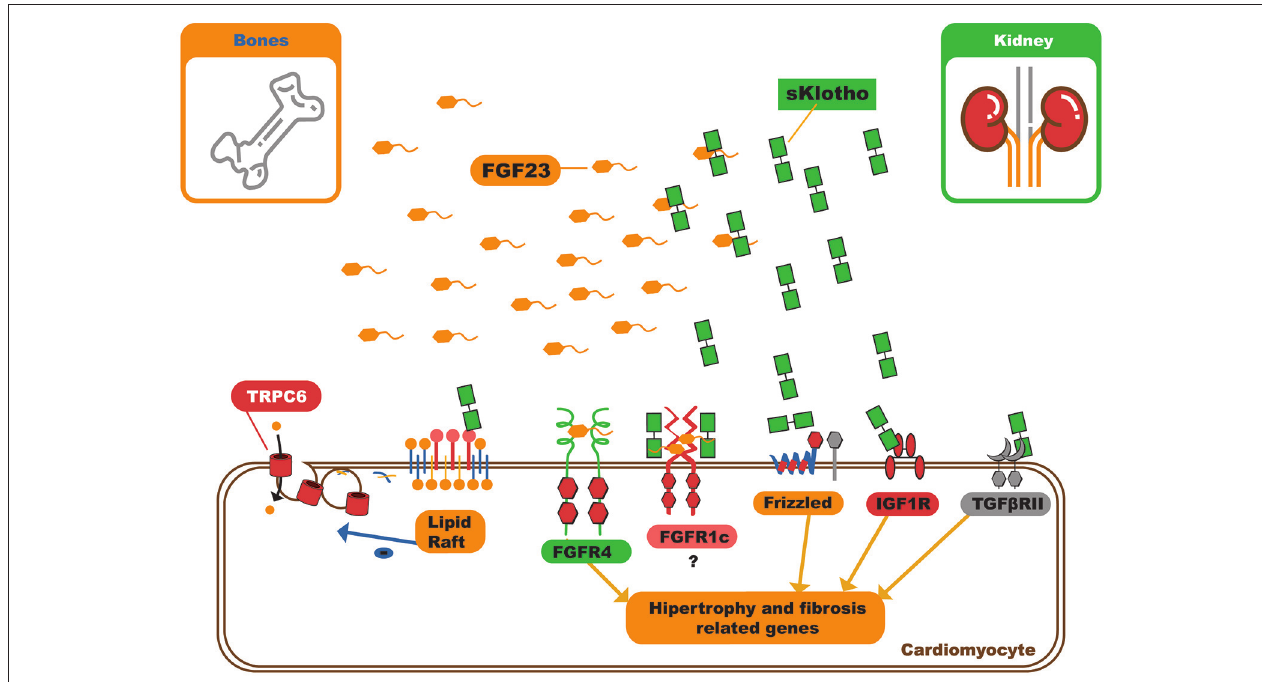
FIGURE 4 | Schematic representation of soluble klotho pleiotropic functions and FGF23 – sKlotho interactions. Soluble klotho can modulate several signaling pathways by receptor or soluble factor biding. In relation to circulating FGF23, soluble klotho can bind it and act in three different ways: First, as decoy receptor leading to FGF23 inactivation or excretion; second, as a bona fide co-receptor, favoring FGF23 biding to FGFR1c, and third, soluble klotho can also serve as a on demand co-receptor to FGFR1c on cardiomyocyte membrane, changing the signaling pathway through FGF23 can act on myocardium. FGF23, Fibroblast growth factor 23; FGFR4, Type 4 fibroblast growth factor receptor; NFAT, Nuclear factor of activated T-cells; FGFR1c, Type 1c fibroblast growth factor receptor; IGF1R, Insulin growth factor 1 receptor; TGF β RII, Type II transforming growth factor β